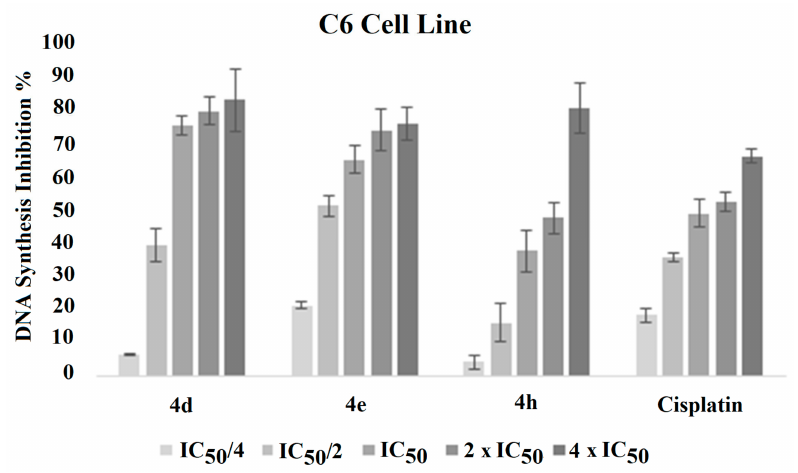
Figure 2. DNA synthesis inhibitory activity % of the compounds 4d , 4e , and 4h and cisplatin against C6 cell line for 24 h incubation